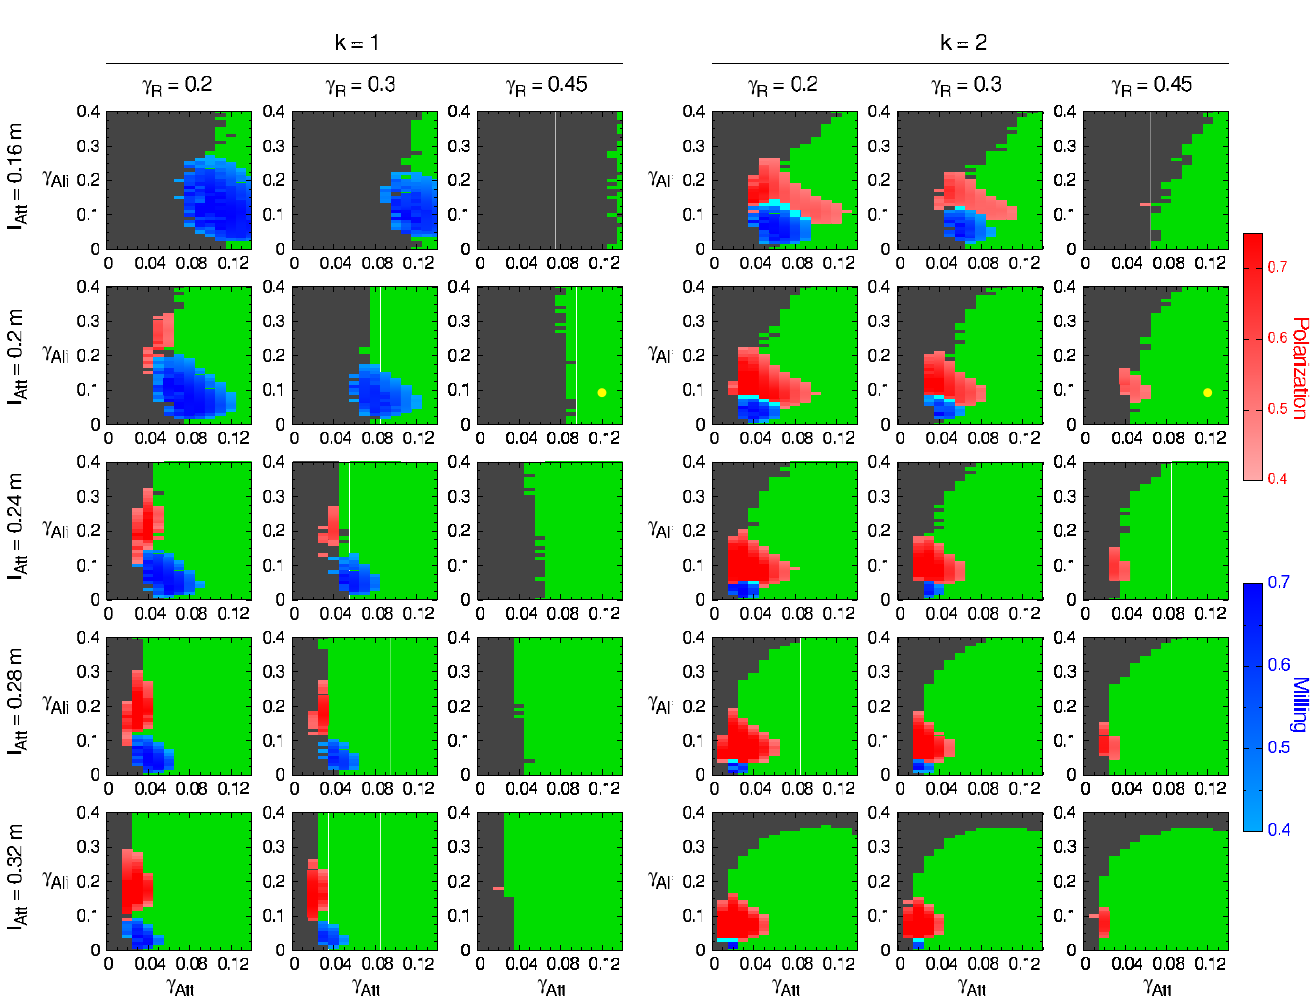
Fig 7. Phase diagrams for k = 1 and 2 for different combinations of the interaction ranges l Att = l Ali and the intensity of random fluctuations γ R . Each row corresponds to a given value of the interaction range; from top to bottom: l Att = l Ali = 0.16, 0.2, 0.24, 0.28, and 0.32 m. Each column corresponds to a given value of random fluctuations; from left to right: γ R = 0.2, 0.3, and 0.45. Color phases are S CHOOLING in red ( P > 0.4), M ILLING in blue ( M > 0.4), and S WARMING in green. Cyan color corresponds to P > 0.4 and M > 0.4. Gray color corresponds to region of high dispersion ( D > 5 m). Values estimated from experiments with pairs of H. rhodostomus swimming in a small circular tank are l Att = l Ali = 0.2 m and γ R = 0.45, marked with a yellow dot in the second row and columns 1 ( k = 1) and 4 ( k = 2). We used a fine discretization with Δ γ = 10 − 2 on both axes.